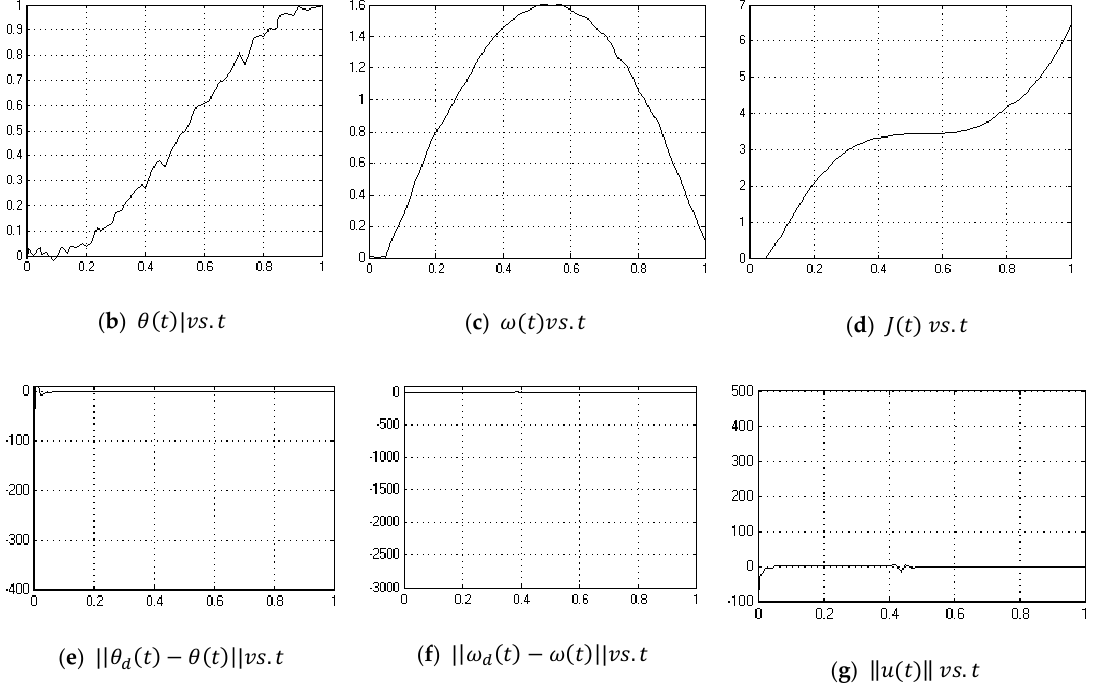
Figure A12. Sampled predictive controlled simulation with noise.